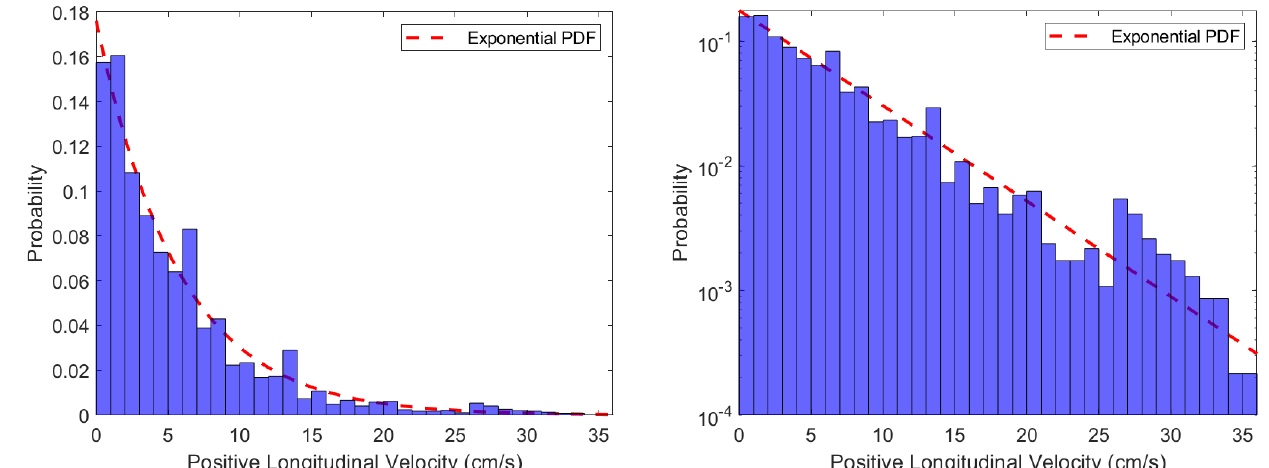
Figure 14. Positive longitudinal forward RoS distribution in linear scale ( left ) and log scale ( right ) with mean µ = 5.68 cm/s, standard deviation σ = 5.63 cm/s, and kurtosis κ = 7.97. The 95% confidence interval for µ is [ 5.52,5.84 ] . The red curve is an exponential distribution with rate parameter λ = 1/ µ = 1.76 × 10 − 1 s/cm. The normalized root mean square error between the exponential curve and the data is 1.93 × 10 − 2